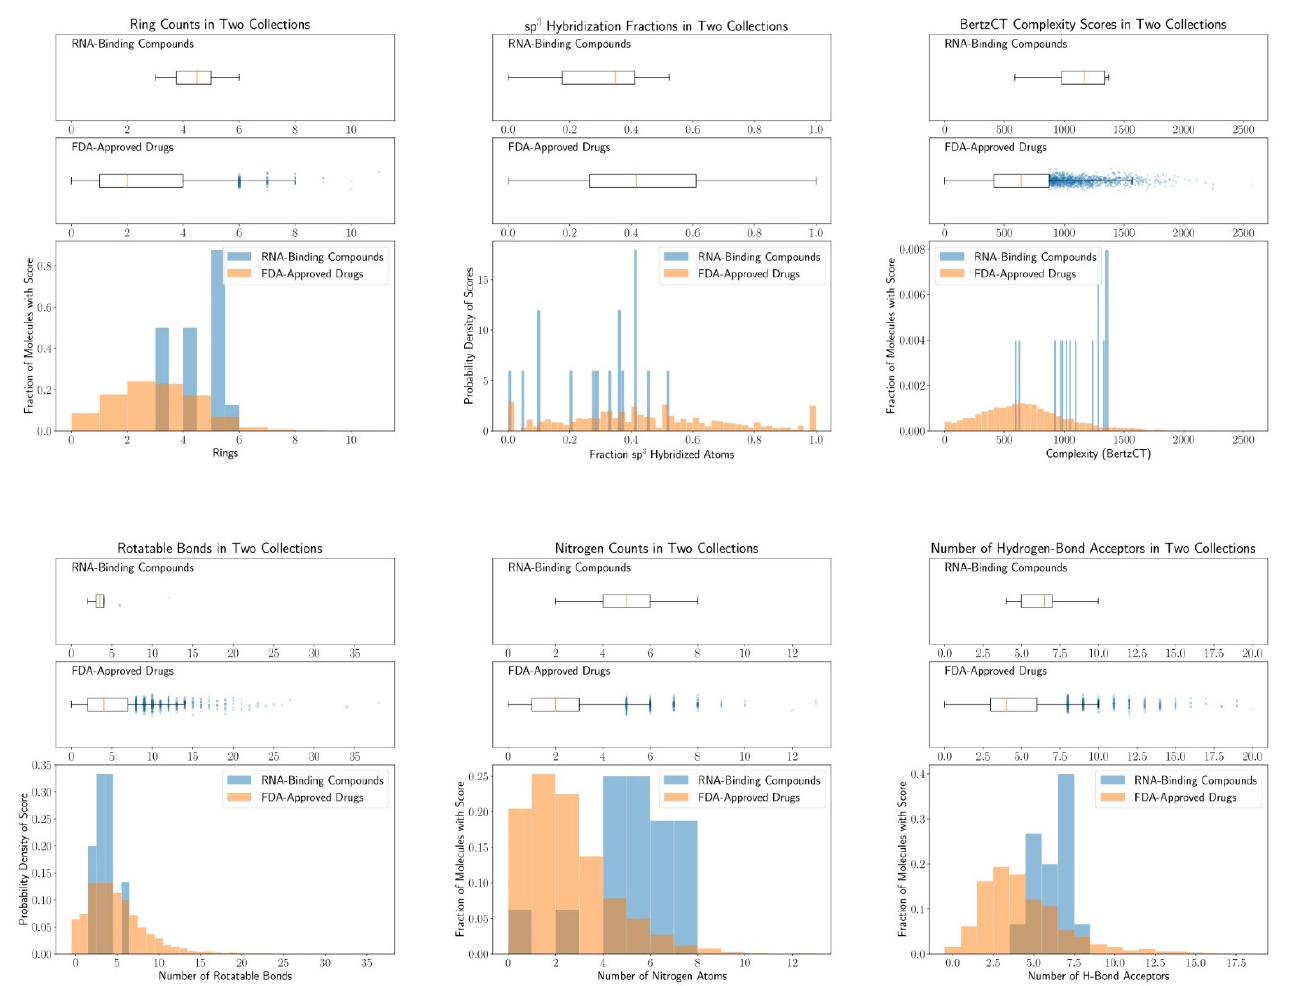
Figure 13. Distribution of key physicochemical properties of the known splicing modifiers and the FDA approved drugs in Table 4.